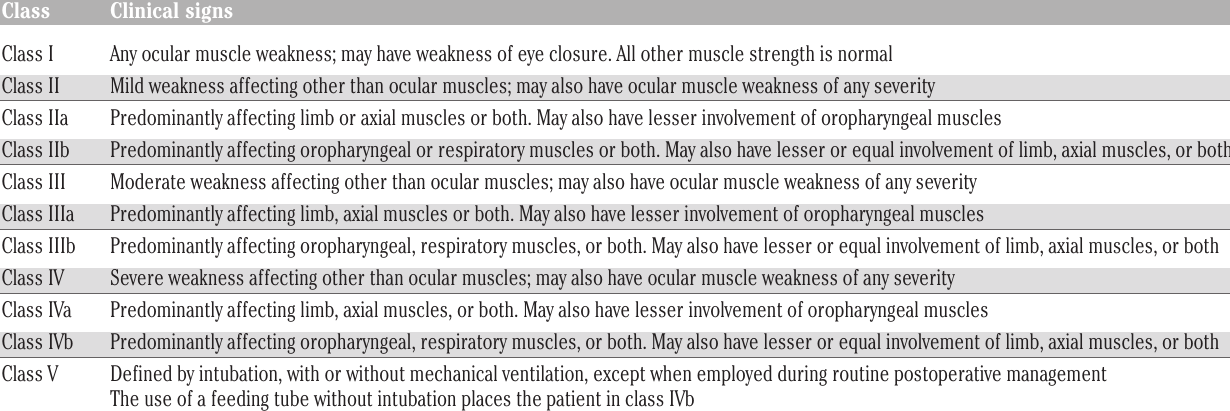
Table 1. Myasthenia gravis Foundation of America clinical